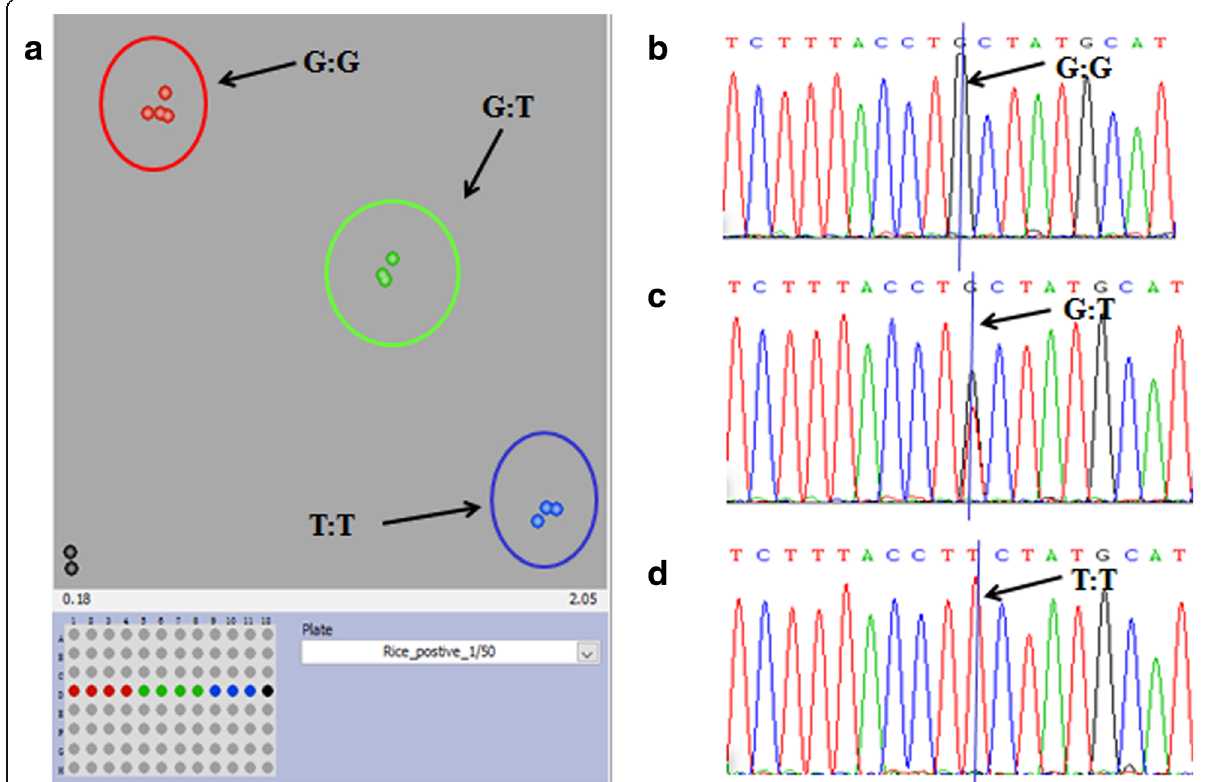
Fig. 4 Results of KASP genotyping and Sanger sequencing. a KASP genotyping of Pita ; b the sequencing peak of the G/G allele; c the sequencing peak of the G/T allele; d the sequencing peak of the T/T